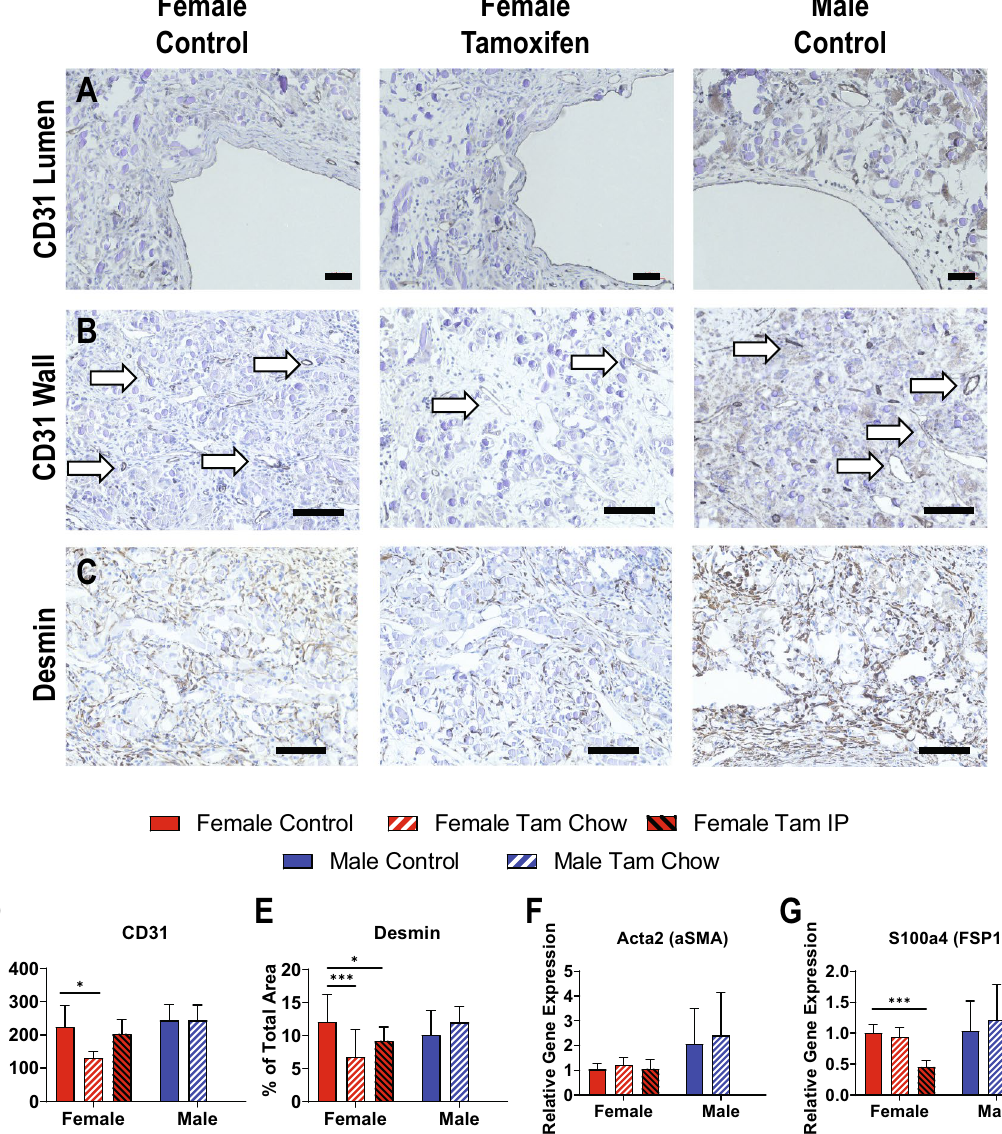
Figure 4. Tamoxifen Effects on Neotissue Cellular Make-Up. ( A ) All TEVGs were endothelialized by 2 weeks as demonstrated by CD-31 staining. ( B ) Walls of TEVGs contained vasa vasorum labeled with white arrows and quantified ( D ). ( C ) Fibroblast and smooth muscle marker desmin staining shown within the TEVG wall and quantified ( E ). RT-qPCR quantification of acta2 ( F ) and S100a4 ( G ) Scale bars = 50 µm ( A ), 200 µm ( B and C ). N = 15–20 for histology measures ( D , E ), and N = 6 for RT-qPCR measures ( F , G ), all compared using t-tests. * p < 0.05, ** p < 0.01, *** p <